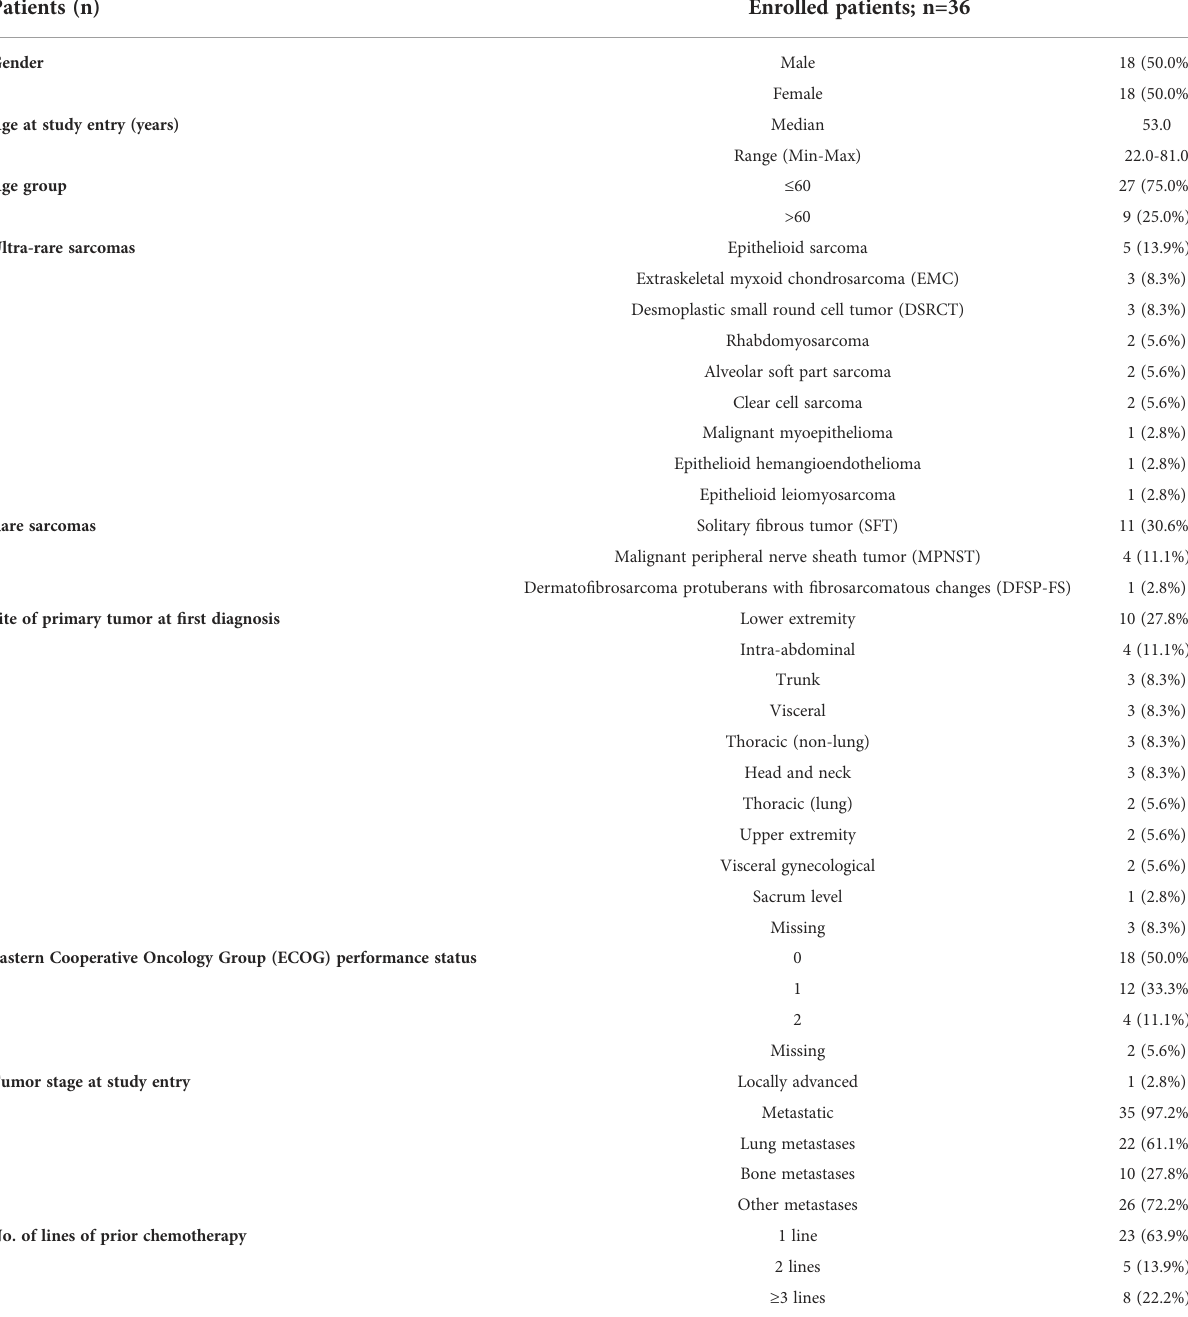
(Table 3). Two patients with epithelioid sarcoma and myoepithelioma had disease stabilization lasting >24 months.